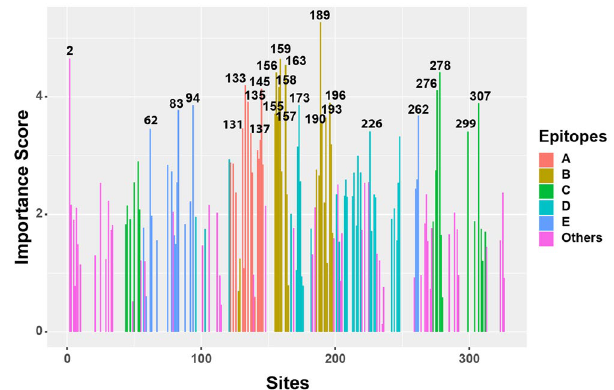
Figure 4. The importance score of all 329 sites predicted by JRFR. The 5 epitopes A, B, C, D, and E are marked in different colors. The remaining sites are classified as